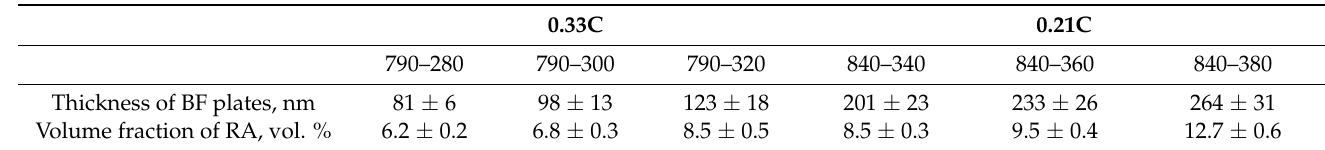
Figure 5. TEM microstructures of both steels after below- Ms and above- Ms austempering. ( a ) 0.33C—280 ◦ C; ( b ) 0.33C—320 ◦ C; ( c ) 0.21C—340 ◦ C; ( d ) 0.21C—380 ◦ C. Table 2. Bainite ferrite laths thickness t B and the content of retained austenite ( V γ ) in austempering samples of both